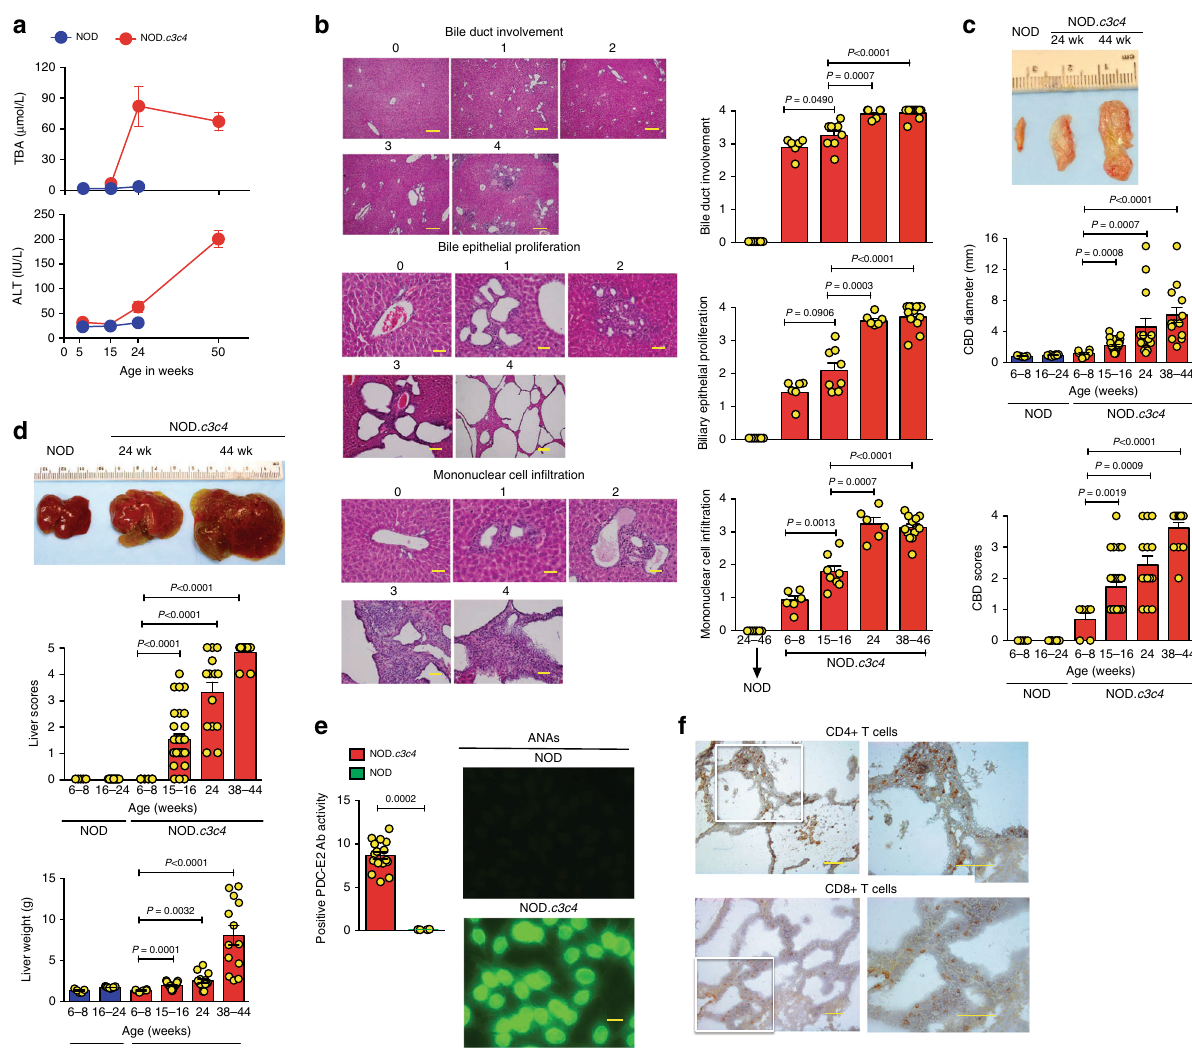
Fig. 2 Clinical, phenotypic, immunological, and pathological features of autoimmune cholangitis in NOD. c3c4 mice. a Changes in serum TBA and ALT levels in NOD vs. NOD. c3c4 mice with age ( n = 5 – 6 and 5/time point, respectively). NOD mice could only be evaluated until 24 weeks of age, owing to loss of mice due to diabetes. b Microscopic scoring system (left) and progression of microscopic scores of disease with age (right). Data correspond to n = 7, 6, 8, 6, and 13 mice from 2 to 3 experiments, from left to right, respectively. Scale bars: top panels: 100 μ m; middle and bottom panels: 25 μ m . c and d Representative CBD images and progression of CBD diameter and scores with age ( c ), and representative liver images ( d , top) and progression of liver scores and weight with age ( d , bottom). Data in c and d correspond to n = 5, 8, 6, 29, 14, and 13 mice from 2 to 3 experiments, respectively. e NOD. c3c4 but not NOD mice spontaneously develop anti-PDC-E2-speci fi c autoantibodies (left; n = 13 and 4 mice/strain type, respectively, from 2 to 3 experiments) and ANAs (right). Photos show representative staining patterns of Hep2 cell nuclei with NOD and NOD. c3c4 sera at 1:160 dilution. Scale bars: 100 μ m. f Representative images of liver in fi ltration by CD4 + and CD8 + T-cells (left: ×20; right: ×40). Scale bars: left photographs: 100 μ m; right photographs: 50 μ m. Averaged data correspond to the mean ± SEM. P values were compared via Mann – Whitney